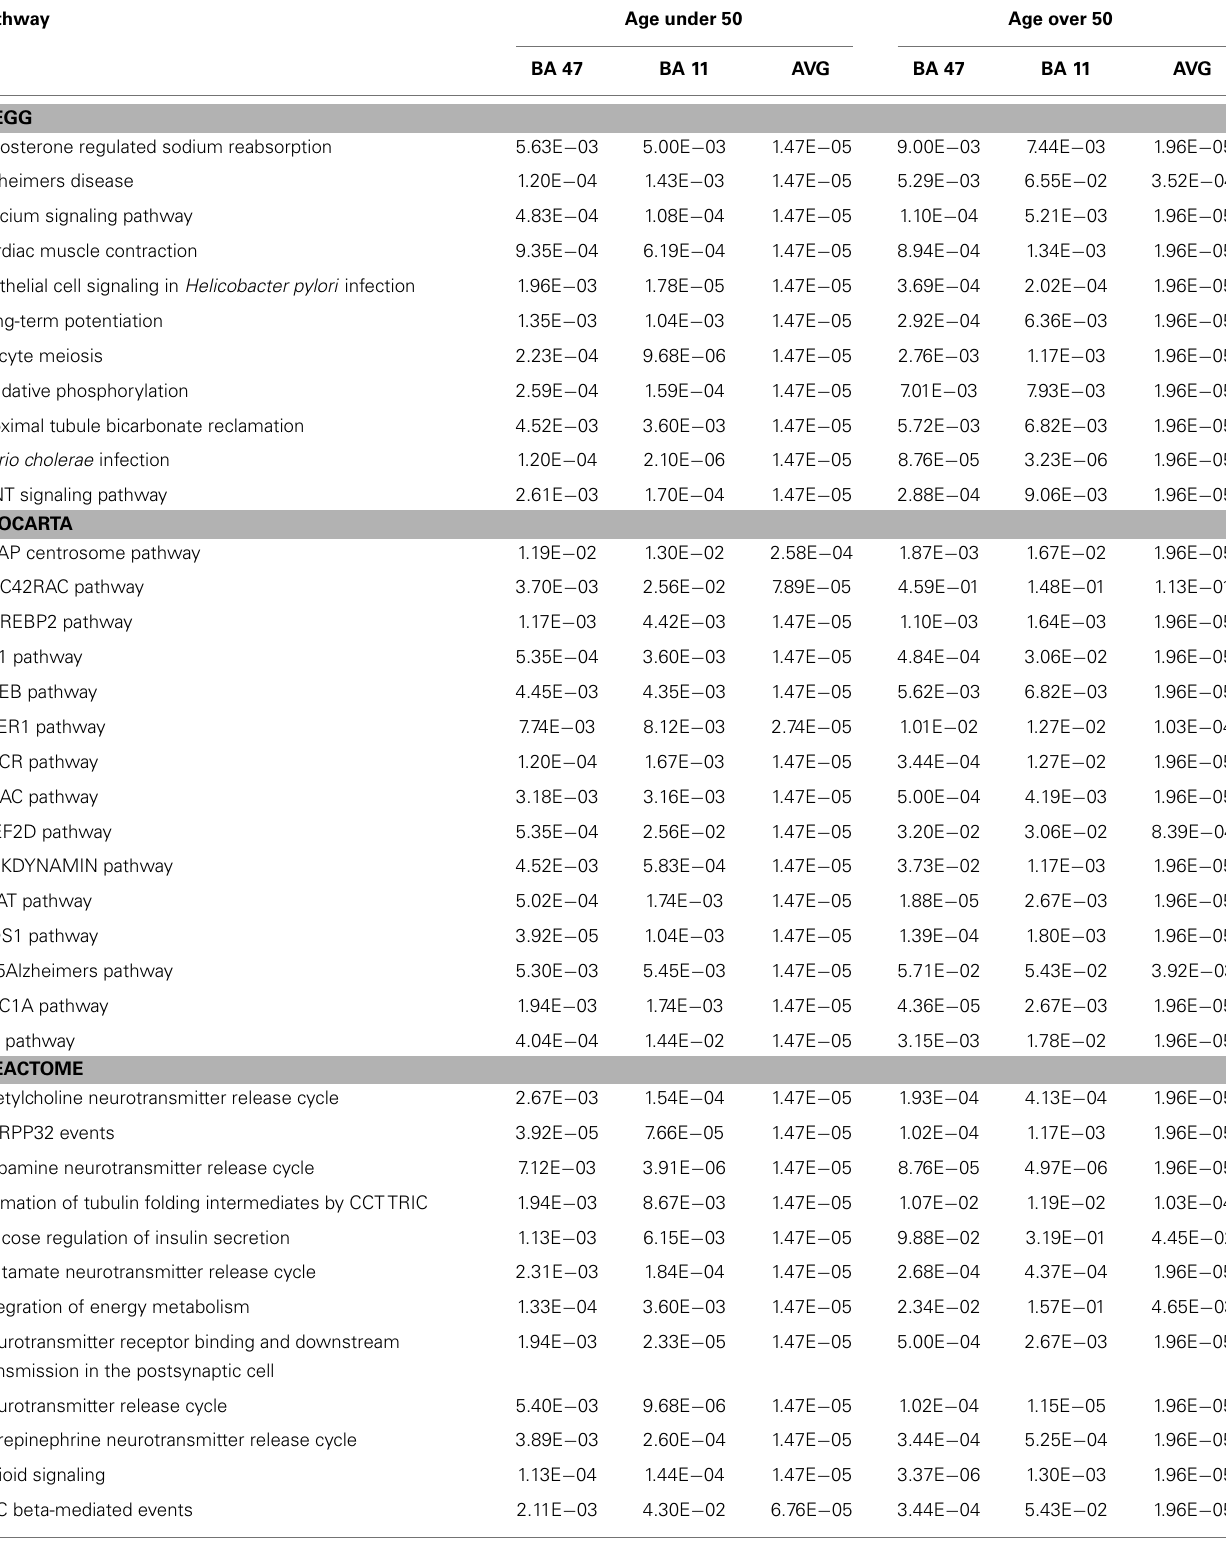
Table 2 |Top pathways identified by genes showing positive correlations withVSNL1 expression .